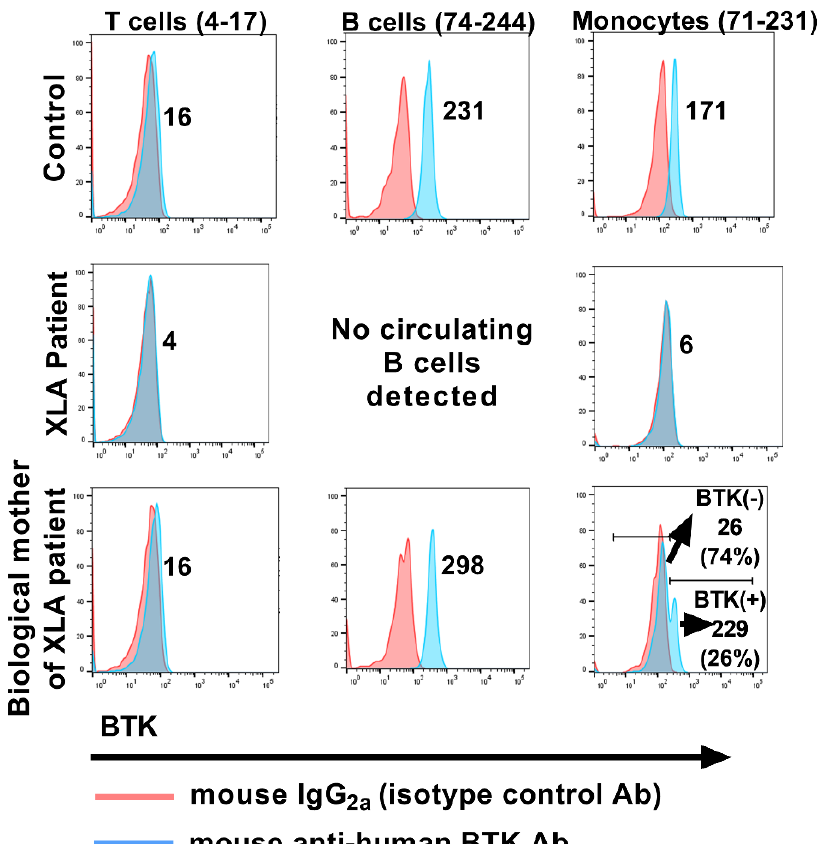
Figure 1. Flow cytometry − based assessment of BTK expression to aid in the clinical diagnosis of XLA. The histogram overlay plots reveal the presence and/or absence of BTK protein expression in the cytosol of the indicated cellular subsets. Circulating T cells, B cells and monocytes were identified by utilizing lineage − directed monoclonal antibodies targeting the surface expression of CD3, CD19 and CD64. Subsequently, cells were fixed, permeabilized and stained with a BTK − specific monoclonal Ab (clone 53/BTK; BD Biosciences, San Jose, CA, USA) to facilitate the detection of cytosolic BTK (blue histograms). The numbers listed in parentheses adjacent to the cell subset label reflect the clinically − validated reference ranges (5th − 95th percentiles) for that particular cell subset, derived from the background − subtracted median fluorescence intensity (MFI) of BTK expression. The numbers listed within each histogram overlay plot reflect the background − subtracted MFI of BTK expression for that specific cell subset for each donor. The histogram overlay plots for the carrier monocytes list the background − subtracted BTK MFI values, as well as the frequency (%) of the BTK(+) and BTK (−) monocytic populations. The specificity of the BTK signal was determined by also separately staining the cells with a dose − matched, isotype control Ab (pink histograms). T cells serve as an additional internal specificity control in the assay, as they lack BTK expression.